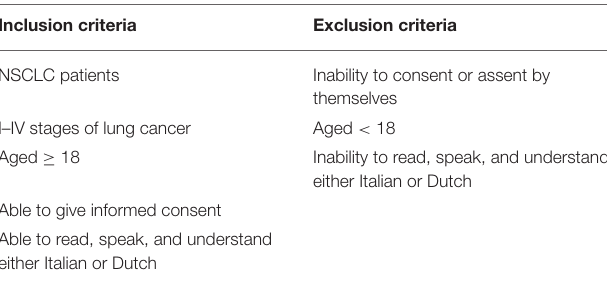
TABLE 1 | Inclusion and exclusion